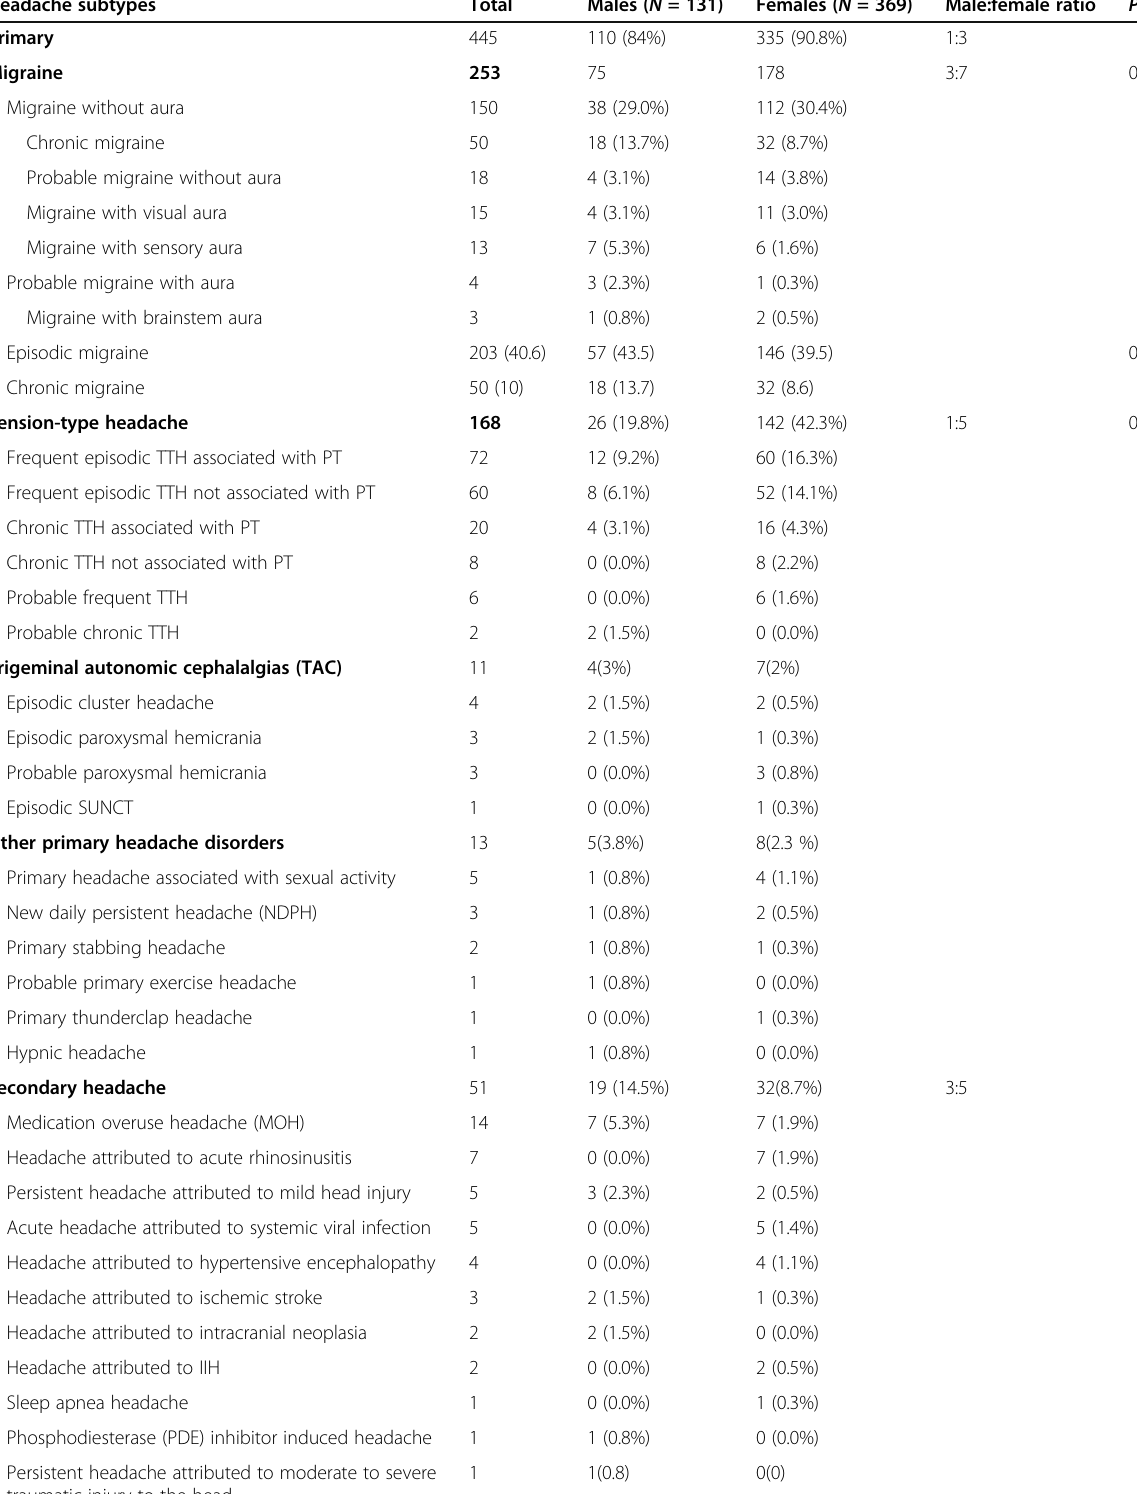
Table 3 Frequency of headache subtypes between male and female Headache